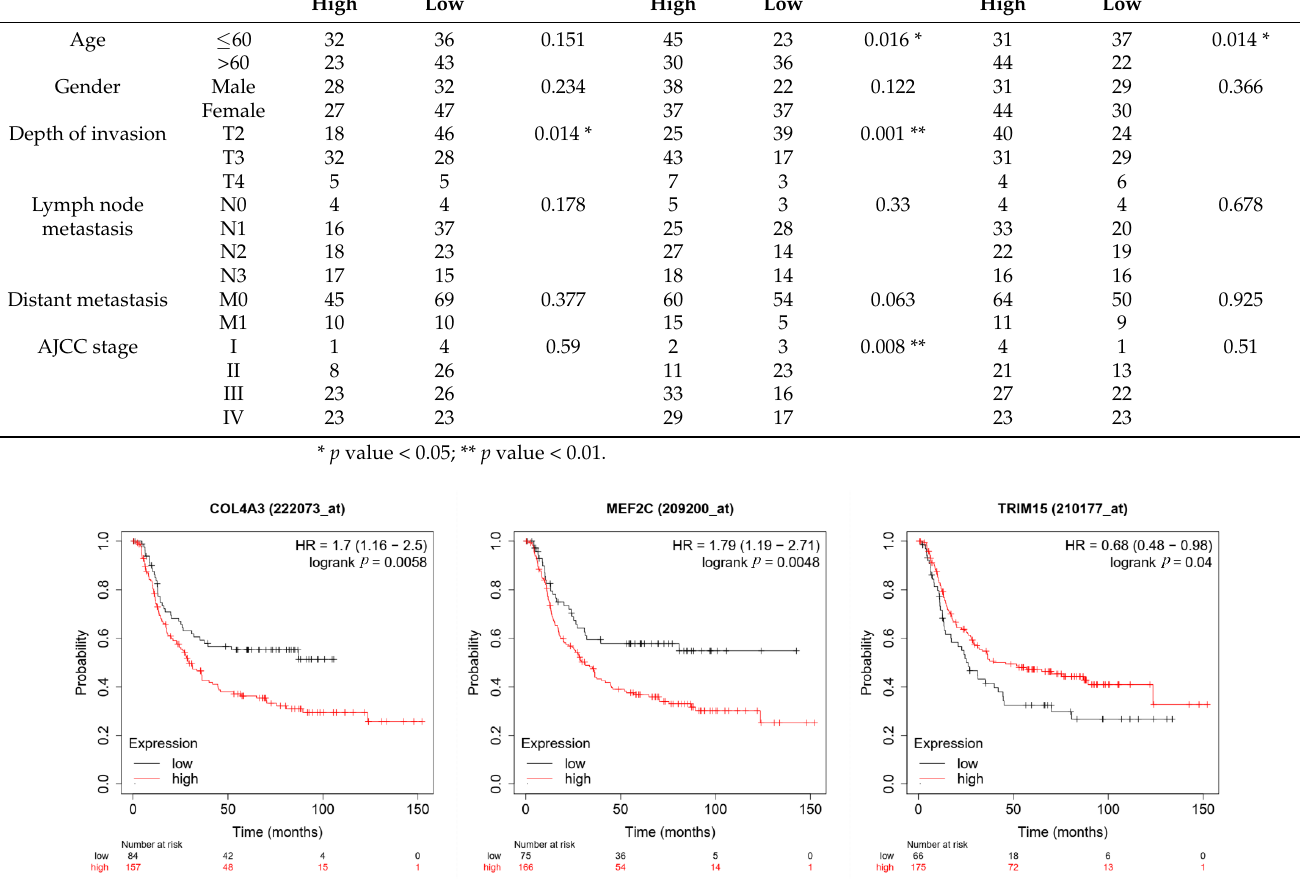
( n = 134) in terms of prognosis.